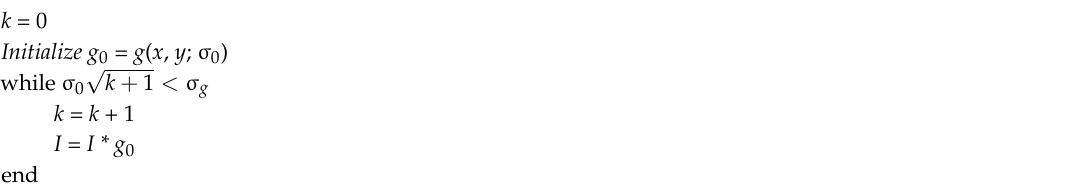
Algorithm 2. The proposed algorithm for calculating the response of a geodetically defined Gaussian kernel on a calibrated fisheye image, for large values of σ .